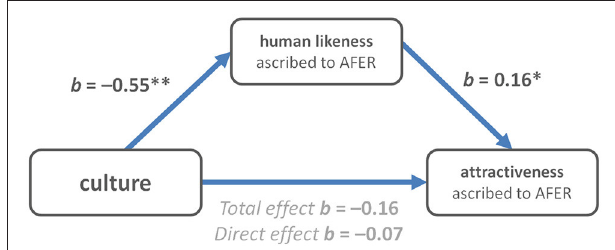
FIGURE 5 | Standardized regression coefficients for the relationship between culture and perceived technology attractiveness as mediated by ascribed technology human likeness. (* p < .05; ** p <